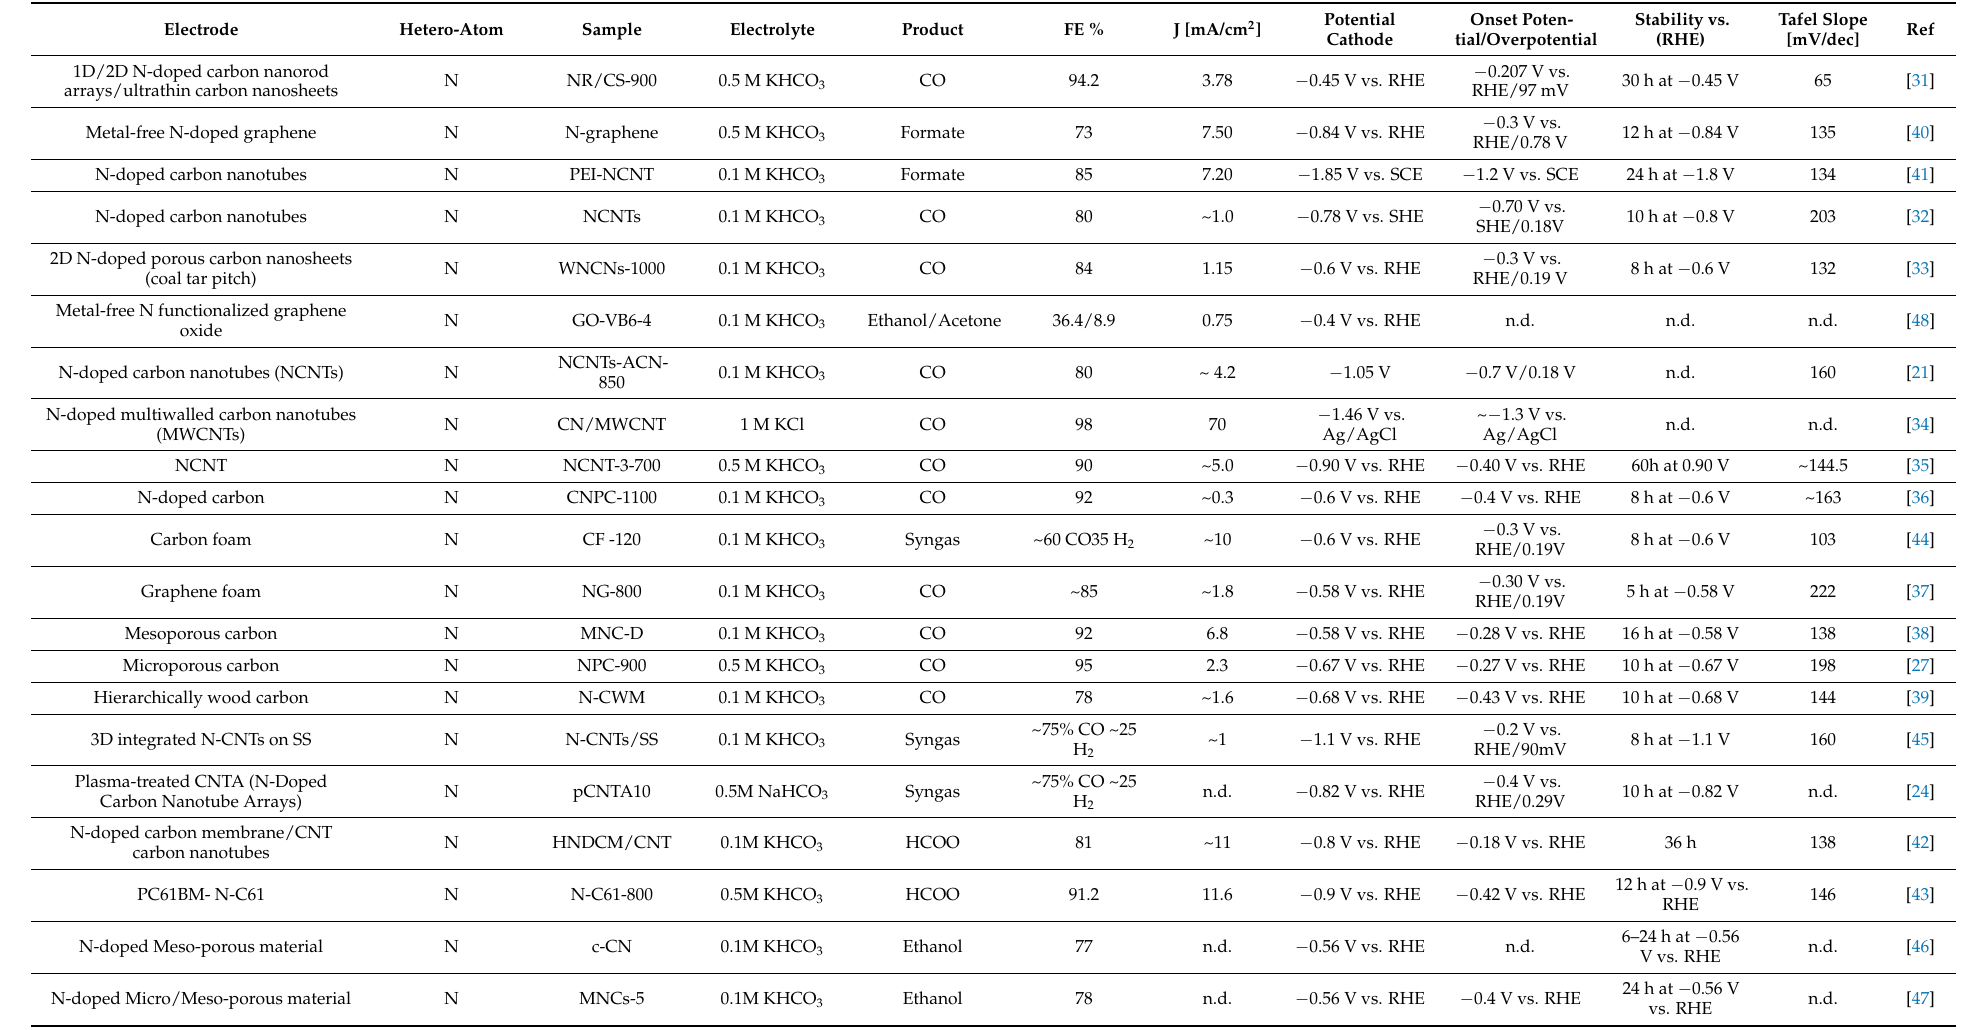
Table 6. Carbon-based materials metal-free doped with heteroatoms as